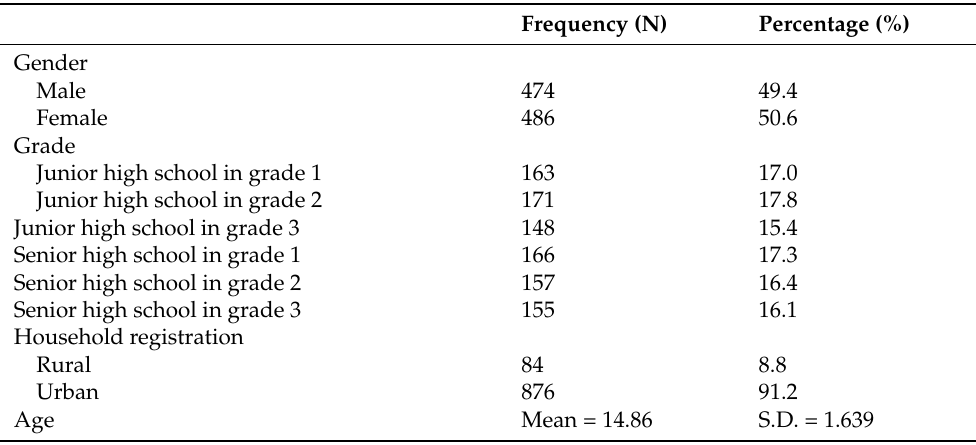
Table 1. The factors are mainly related to gender, grade, age, and household registration. Table 1. Sociodemographic characteristics (N =